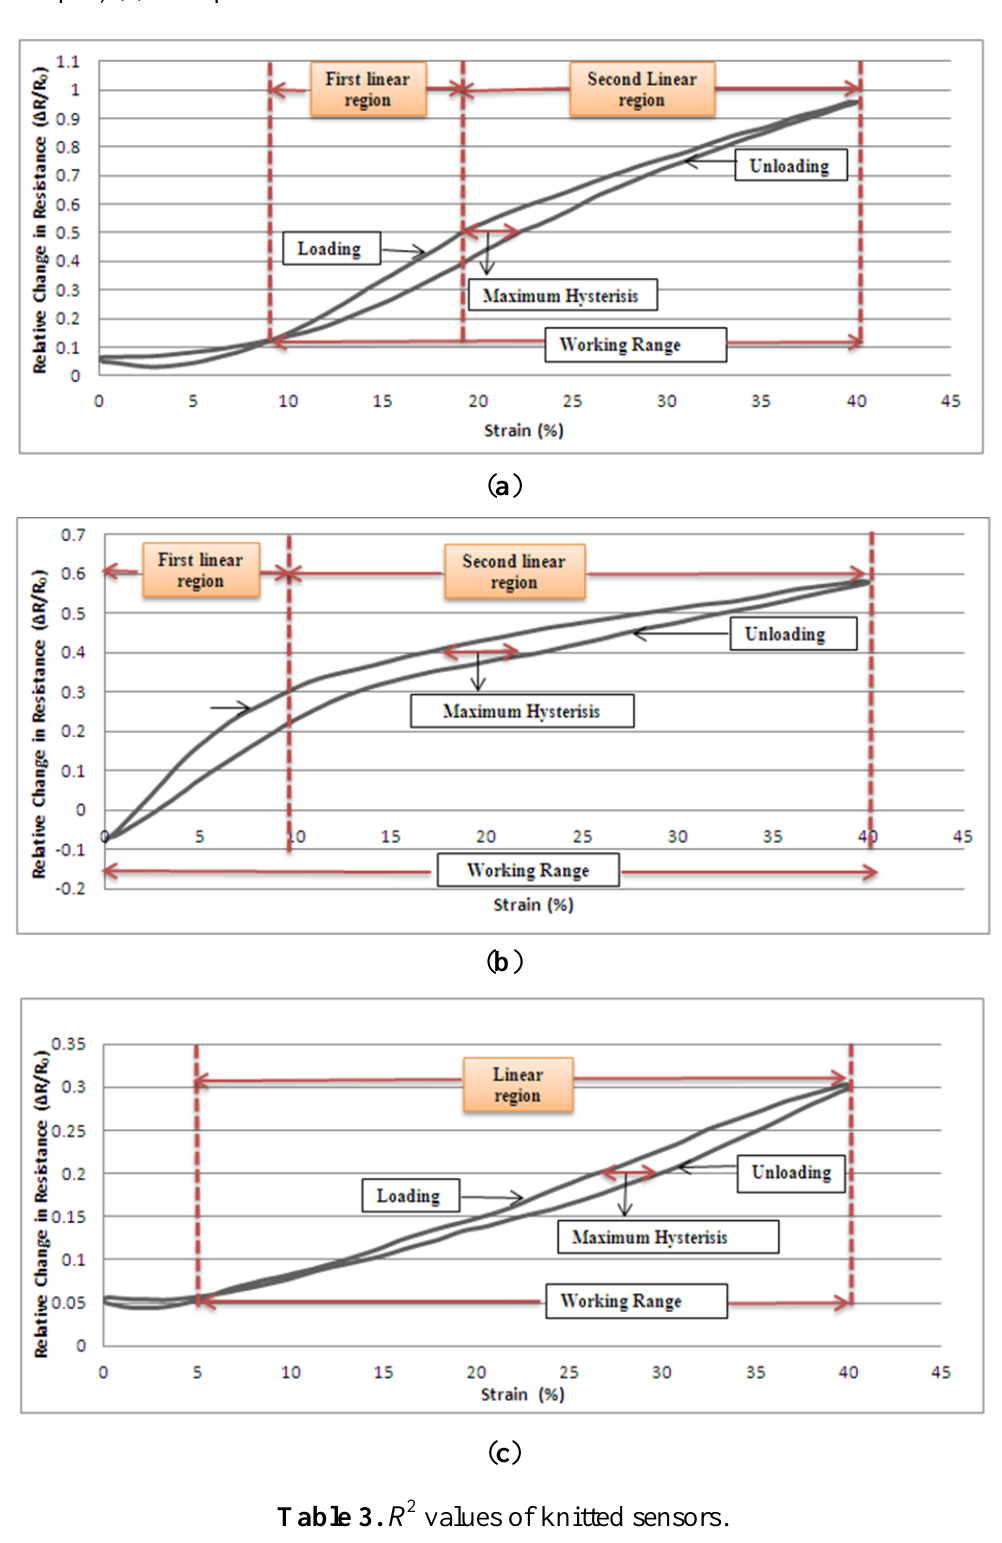
Figure 5. Relative change in resistance-strain graphs of three groups. ( a ) Group 1; ( b ) Group 2; ( c ) Group 3.